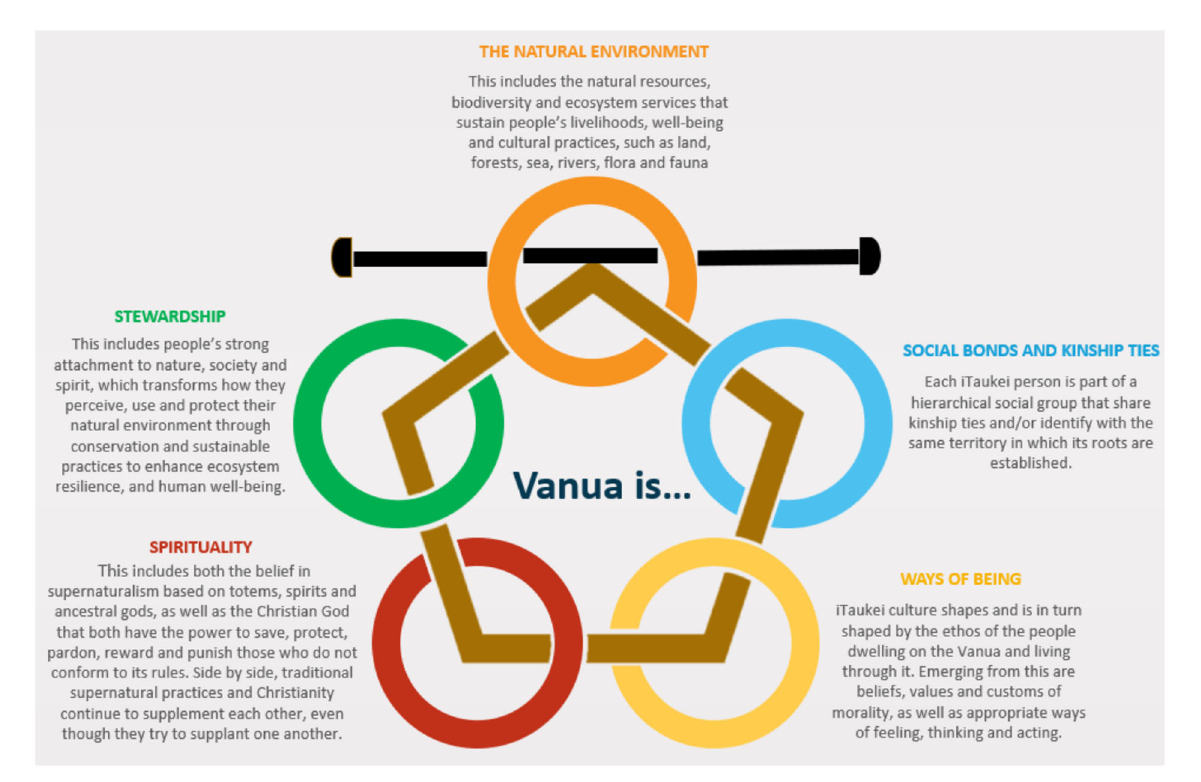
FIGURE2 Vanua: at the epicenter of iTaukei culture (developed from presentationgo.com